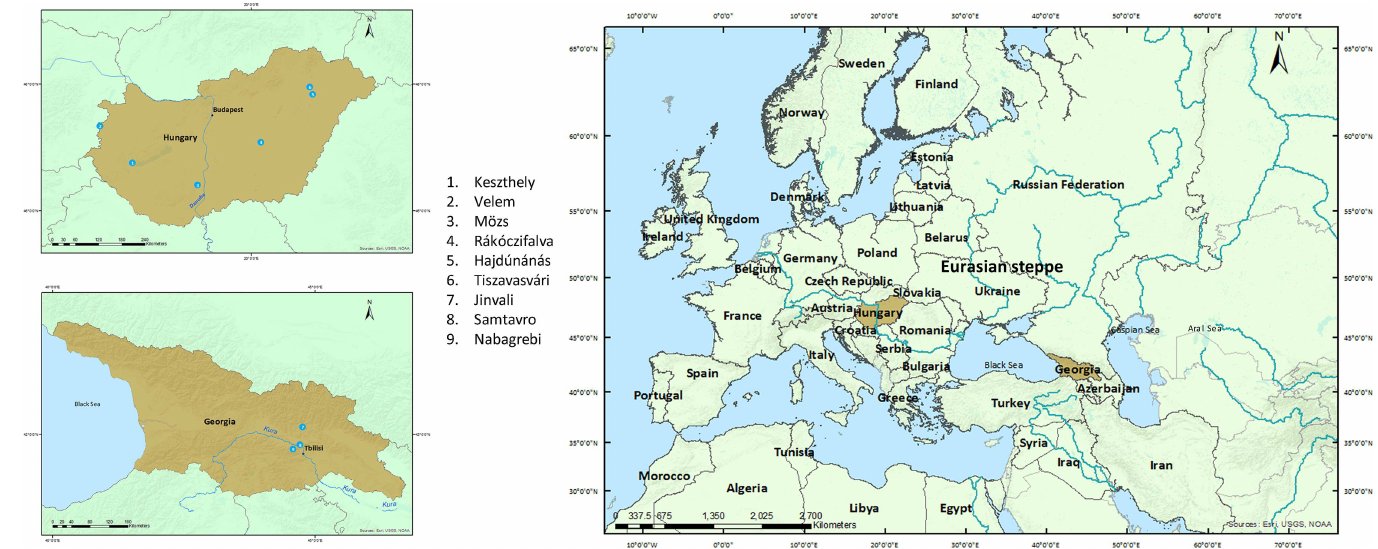
Fig 1. Map of Europe highlighting Hungary and Georgia and the locations of sites with modified